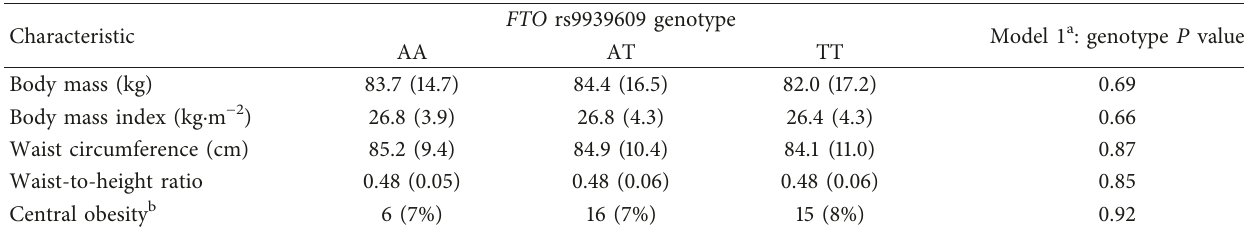
Table 2: Obesity-related parameters in men and women carrying different risk variants of the FTO rs9939609 single nucleotide polymorphism.